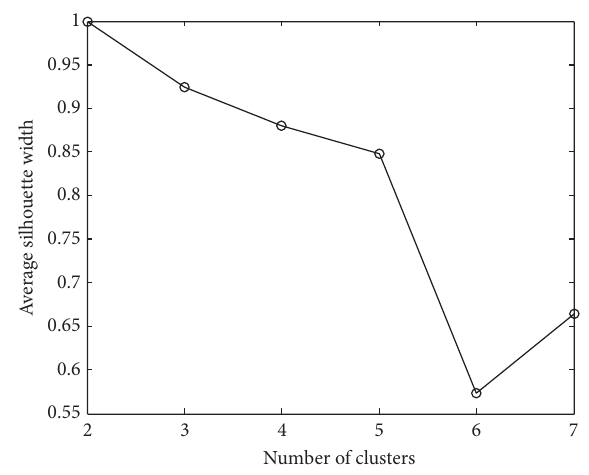
Figure 7: Fourier spectrum of acceleration response.